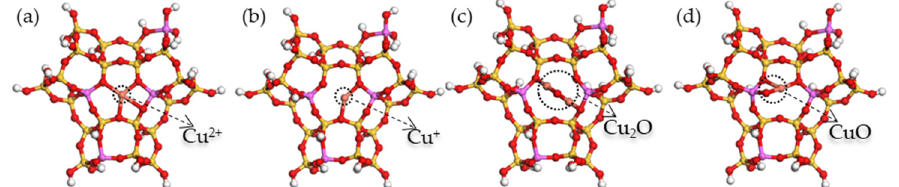
Figure 4. The stable cluster geometries of ( a ) Cu 2+ Y, ( b ) Cu + Y, ( c ) Cu 2 O-Y and ( d ) CuO-Y zeolites. Red, yellow, pink, white and orange balls stand for O, Si, Al, H and Cu atoms, respectively.